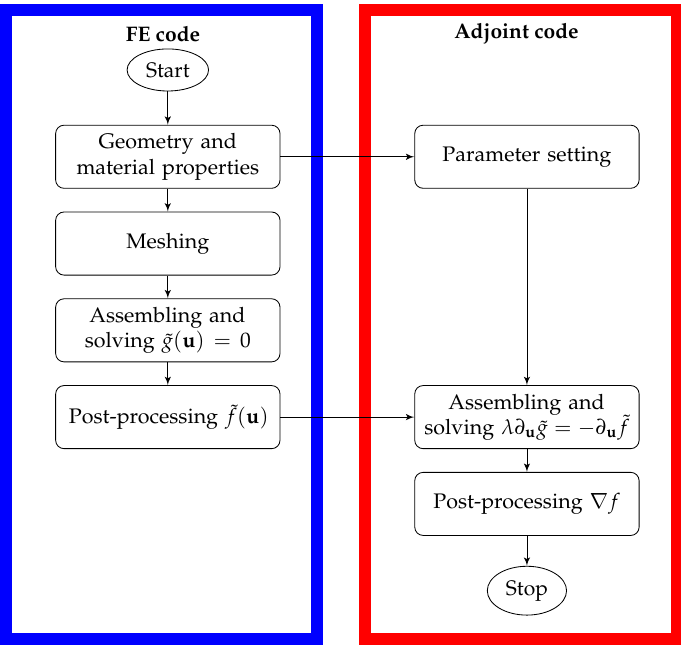
Figure 12. Flowchart of a modular adjoint